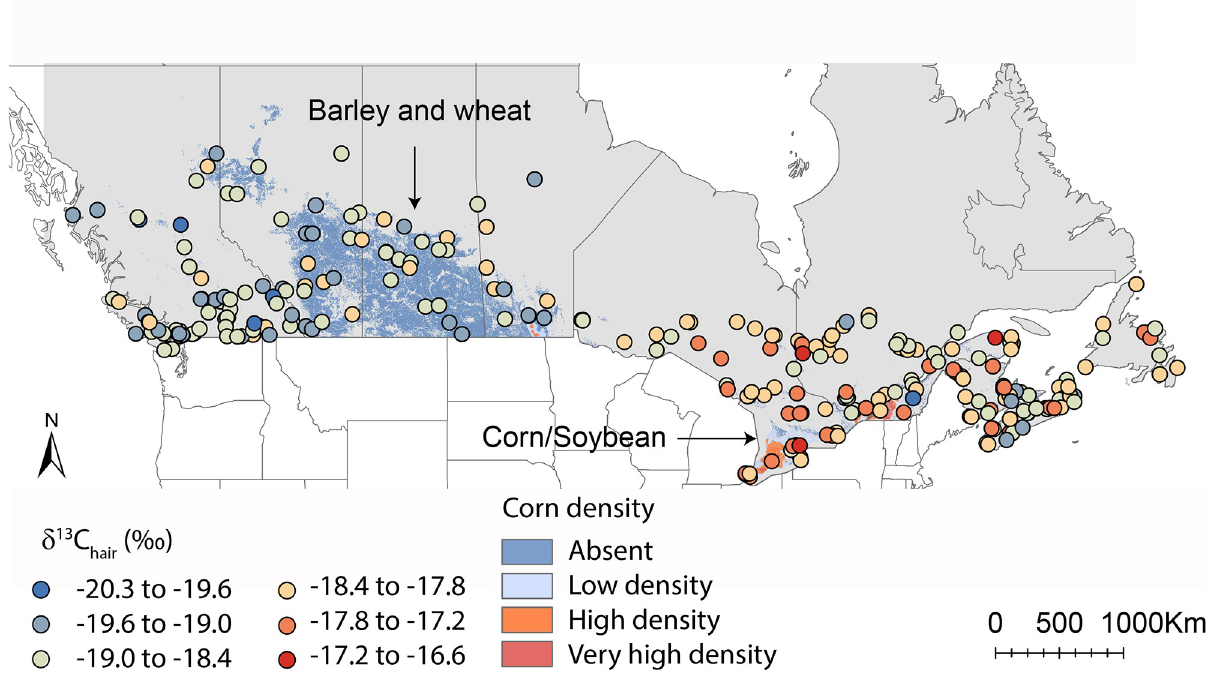
Fig 6. Distribution of carbon isotope variations in hair of donors and density of corn production across Canada. Color scale represents the spatial density of corn crops on agricultural land relative to other C 3 crops for the year 2011 (http://open.canada.ca/data). This map contains information licensed under the Open Government Licence–Canada. Administrative boundaries are from http://www.naturalearthdata.com/. This map was generated in Rx64 3 4.2